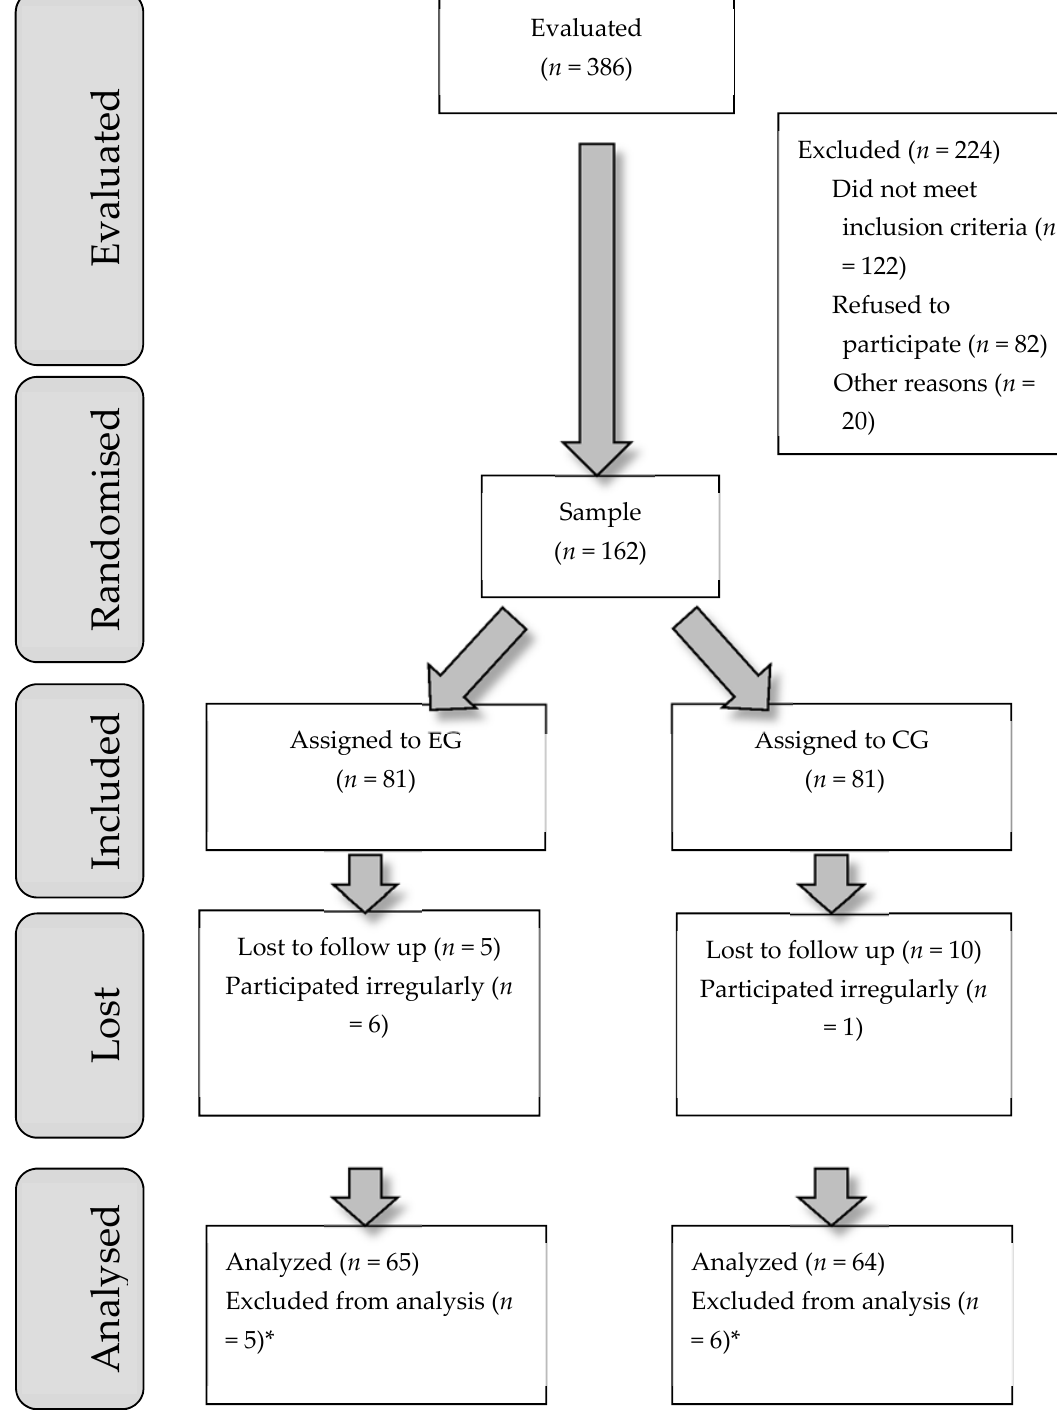
Figure 1. Flow diagram. * The delivery did not take place at the Granada Hospital